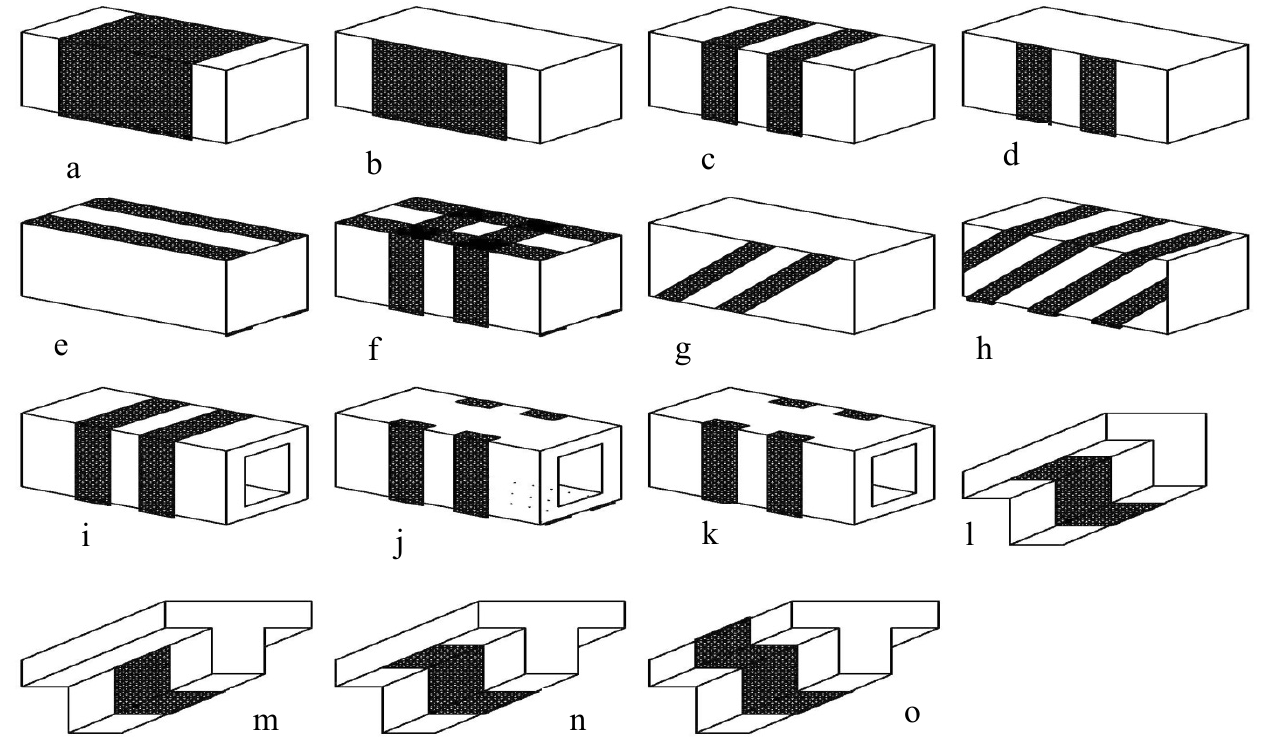
Figure 1. Torsion strengthening schemes using FRP ( a ) Entire beam for rectangular beam; ( b ) U entire beam for rectangular beam; ( c ) 90 strips for rectangular beam; ( d ) U strips for rectangular beam; ( e ) Longitudinal strips for rectangular beam; ( f ) 90 strips and longitudinal strips for rectangular beam; ( g ) 45 strips one side for rectangular beam; ( h ) 45 strips spiral around beam for rectangular beam; ( i ) 90 strips for box beam; ( j ) U anchorage strips and longitudinal strips for box beam; ( k ) U anchorage strips for box beam; ( l ) Extended U entire beam for spandrel beam (with multiple FRP orientations); ( m ) U entire beam for T beam; ( n ) Extended U entire beam for T beam; ( o ) Entire beam for T beam.